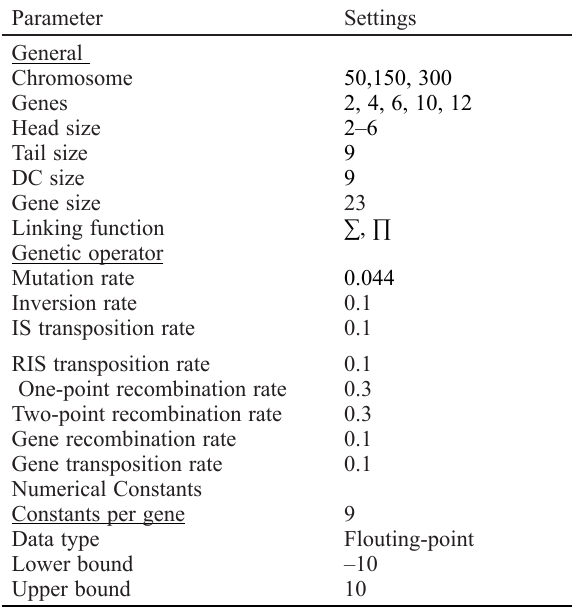
Table 1. Parameter settings for the GP algorithm Parameter Settings General